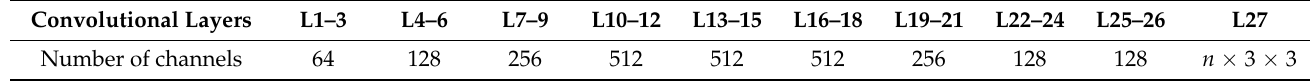
Table 1. The number of channels in each convolutional layer of the offset-prediction subnet. Convolutional Layers